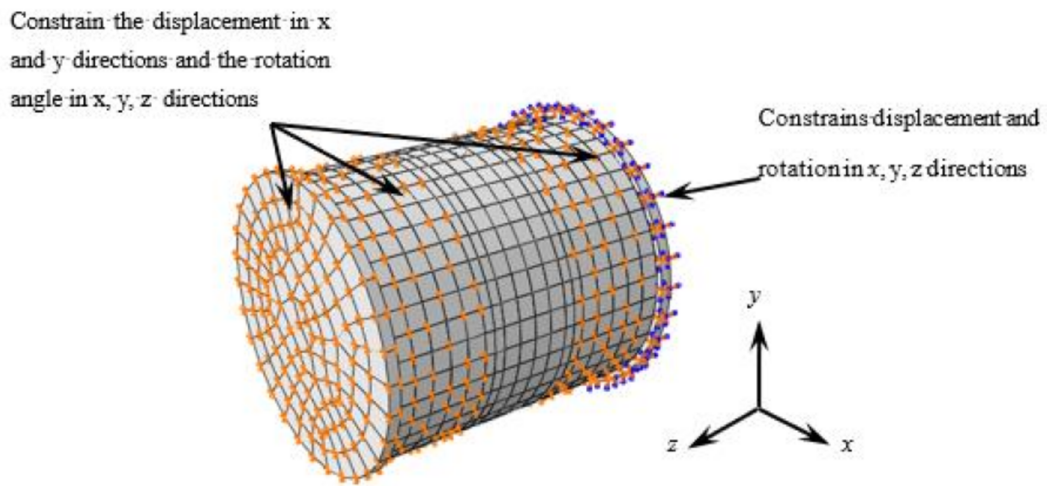
Figure 8. Boundary conditions.